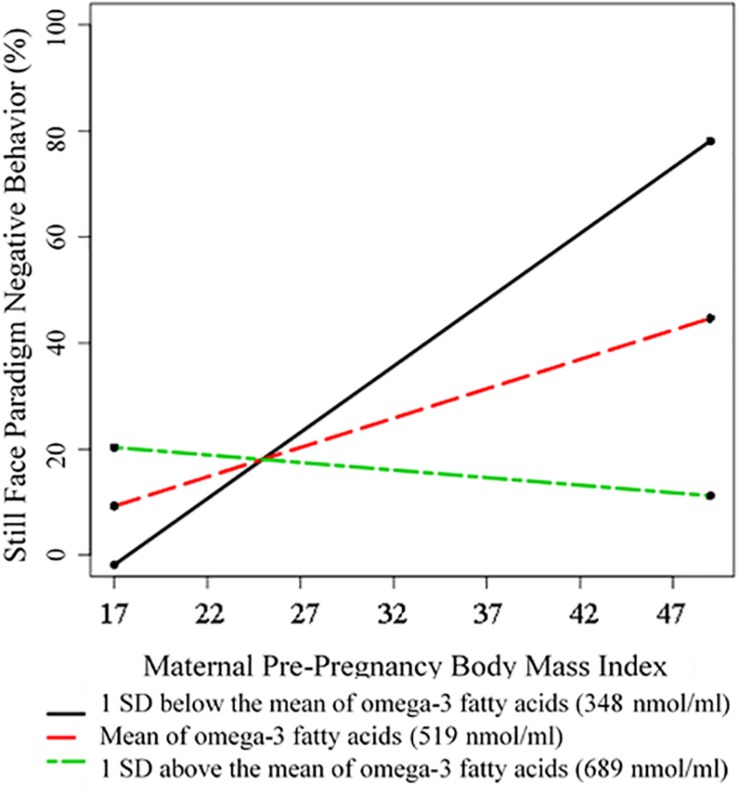
Visual Depiction of the Interaction between Maternal Pre-Pregnancy BMI and Omega-3 Fatty Acids in Predicting Infant Negative Behavior during the Still Face Paradigm. Omega-3 fatty acid levels were treated as a continuous variable in all analyses. However, for the purposes of visualization, we employed the pick-a-point method and probed this interaction following the direction of Preacher et al. (2006). The pick-a-point approach involves selecting three values of your moderator and plotting the model-implied regression lines for these three values, as a way to visually illustrate the nature of the interaction (it does not affect the moderation analyses, where levels of omega-3 fatty acid concentrations were treated as a continuous variable). Following convention, in this figure we have plotted the model-implied slopes that correspond to our sample mean, one standard deviation above our sample mean, and one standard deviation below our sample mean of circulating omega-3 fatty acid concentrations.